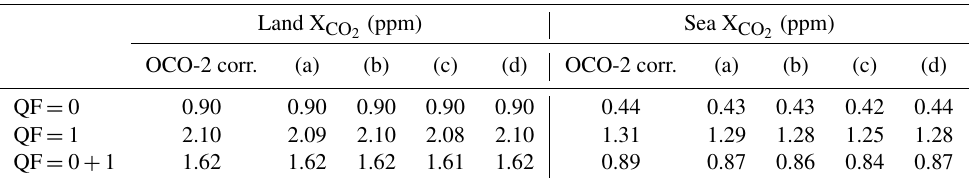
Figure 5. X CO bias vs. cloud distance for OCO-2 soundings over land (a) , soundings over land corrected by our proposed method (b) , 2 OCO-2 soundings over sea (c) , and soundings over sea that are corrected (d) for QF = 0 and QF = 1 data from 2018 to 2019. The 5th and 95th percentiles are indicated by the yellow shaded area, the mean is shown by a red line, and individual comparisons are shown by gray dots. Table 4. RMSE of X CO as determined by small-area analysis for the testing set (August 2018 –July 2019). The RMSE is shown for 2 the proposed bias correction approach (OCO-2 corr.) and using the same approach but with additional features. In addition to the variables determined by the recursive feature elimination, (a) shows nearest-cloud distance; (b) shows CSNoiseRatio; (c) shows nearest-cloud distance, CSNoiseRatio, HC, and H3D; and (d) shows